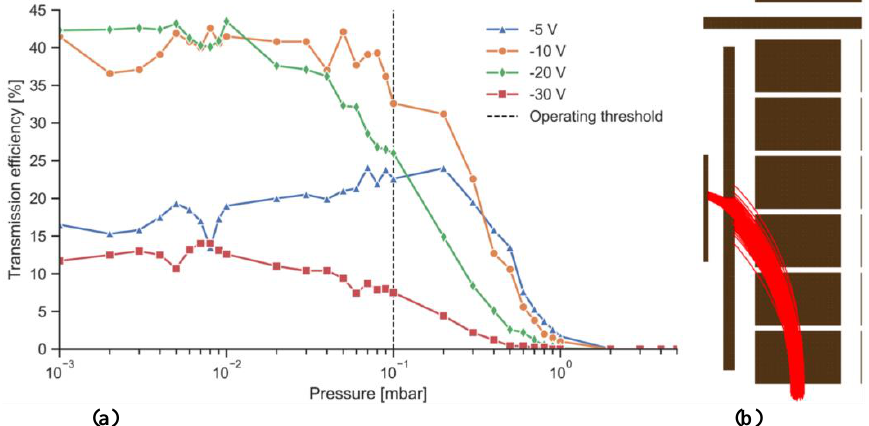
Fig. 6 . (a) Simulated ion transmission in the mbar range (b) Example of ion motion with only an applied DC potential at 1 x 10 -2